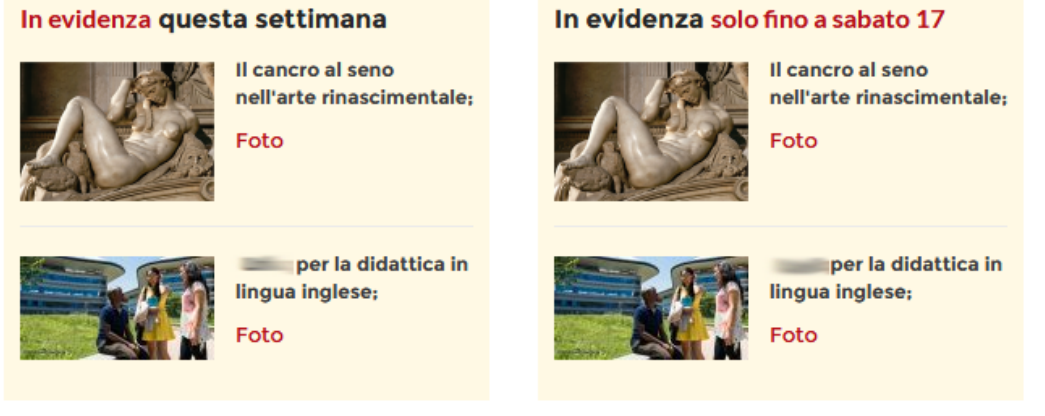
Figure 4. Recommended news with positive framing ( left ) and negative framing ( right